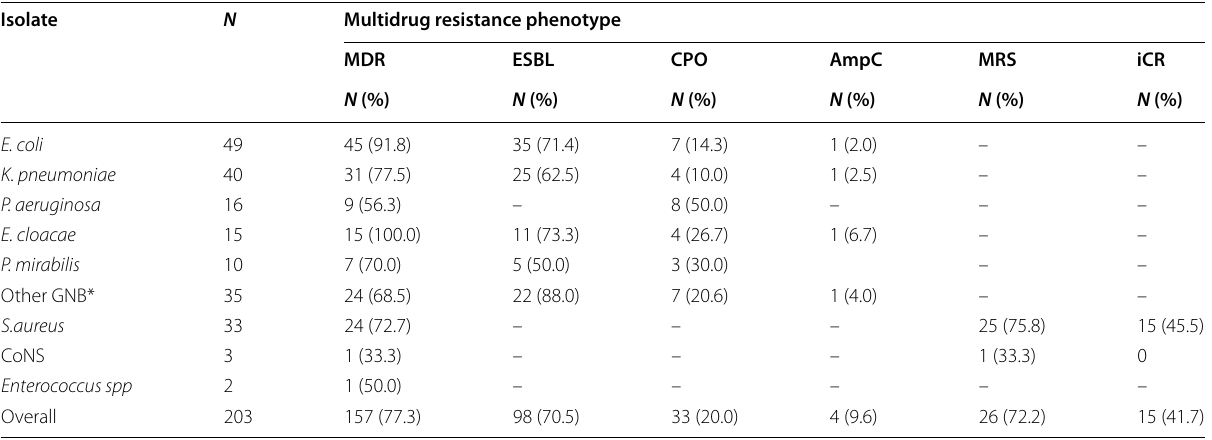
Table 2 Proportion of multidrug resistance phenotypes of bacterial pathogens causing UTI among men with prostate enlargement at Muhimbili National Hospital, Dar es